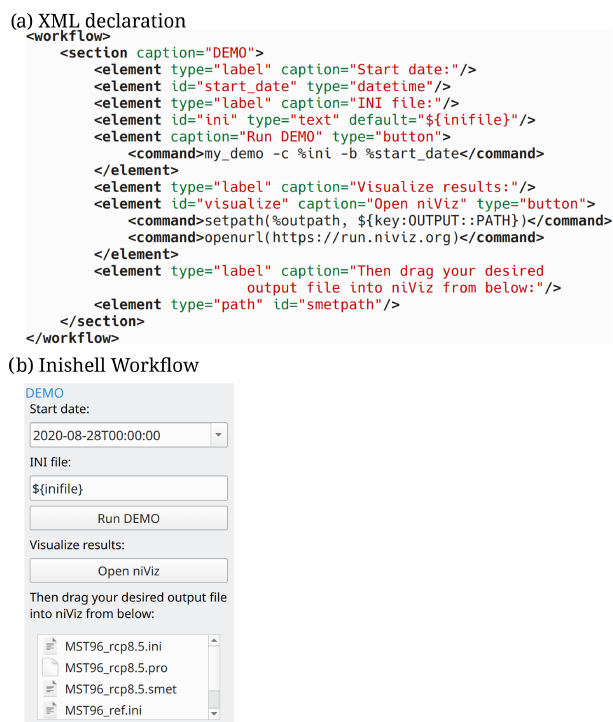
Figure 10. Example of a workflow panel: a few command line pa- rameters must be provided by the user, who can then run the numer- ical model and open a visualization